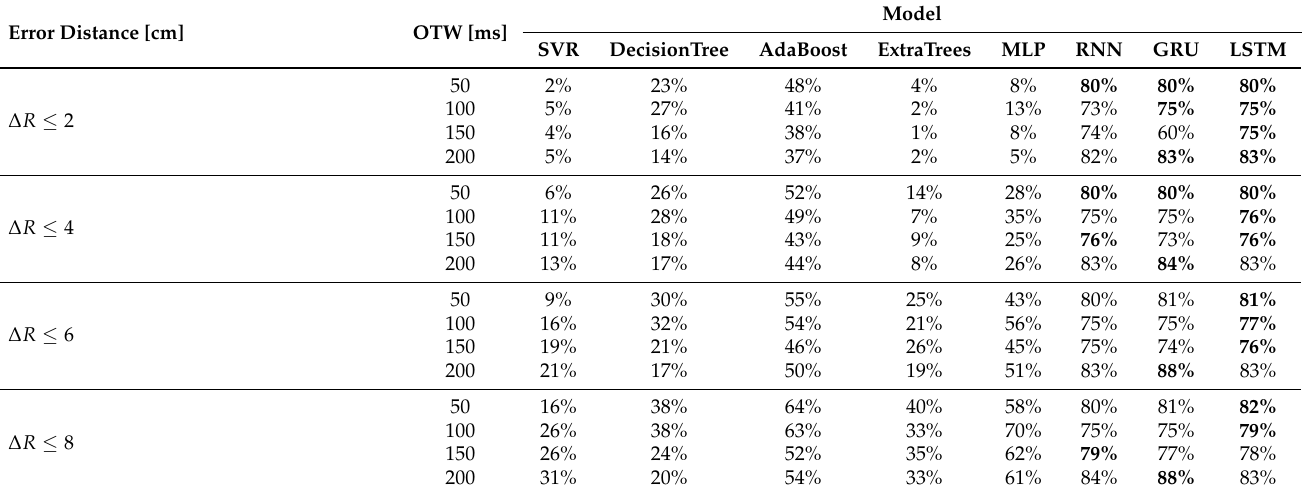
Table 2. Comparison of prediction accuracy for placing task using different models, with all sensor